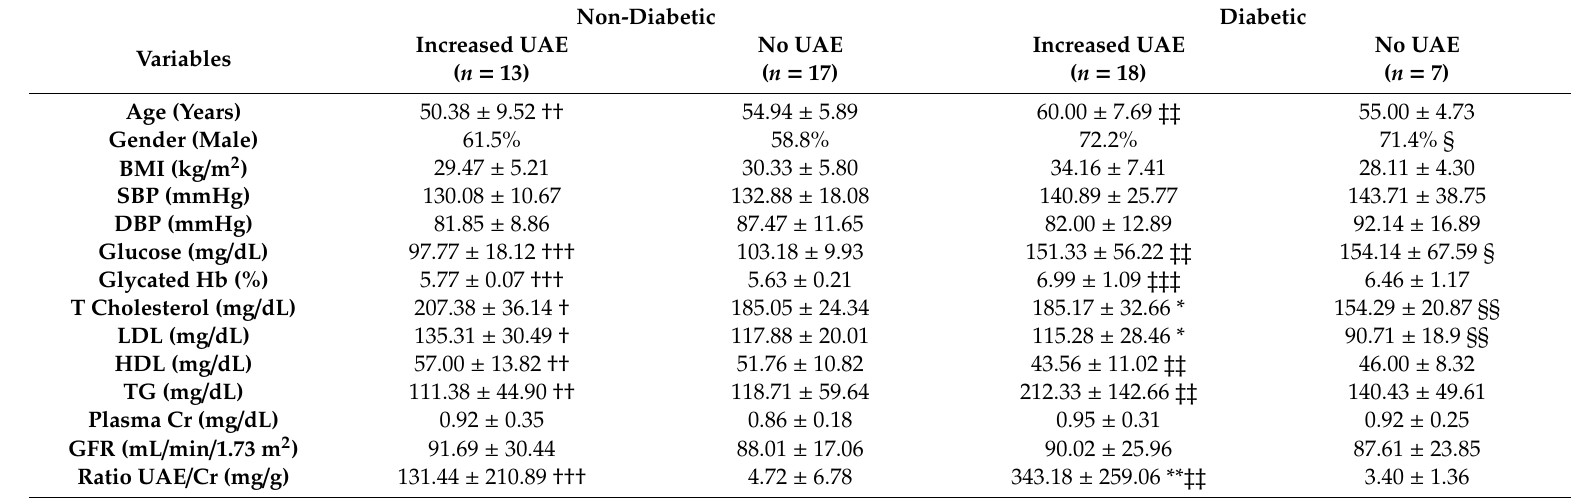
Table 1. Clinical characteristics of hypertensive patients divided in study